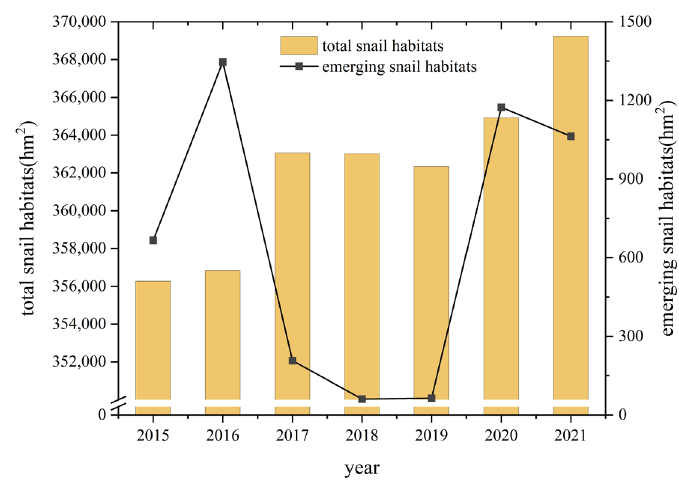
Figure 2. Changes of snail burden in the YEB during 2015–2021.